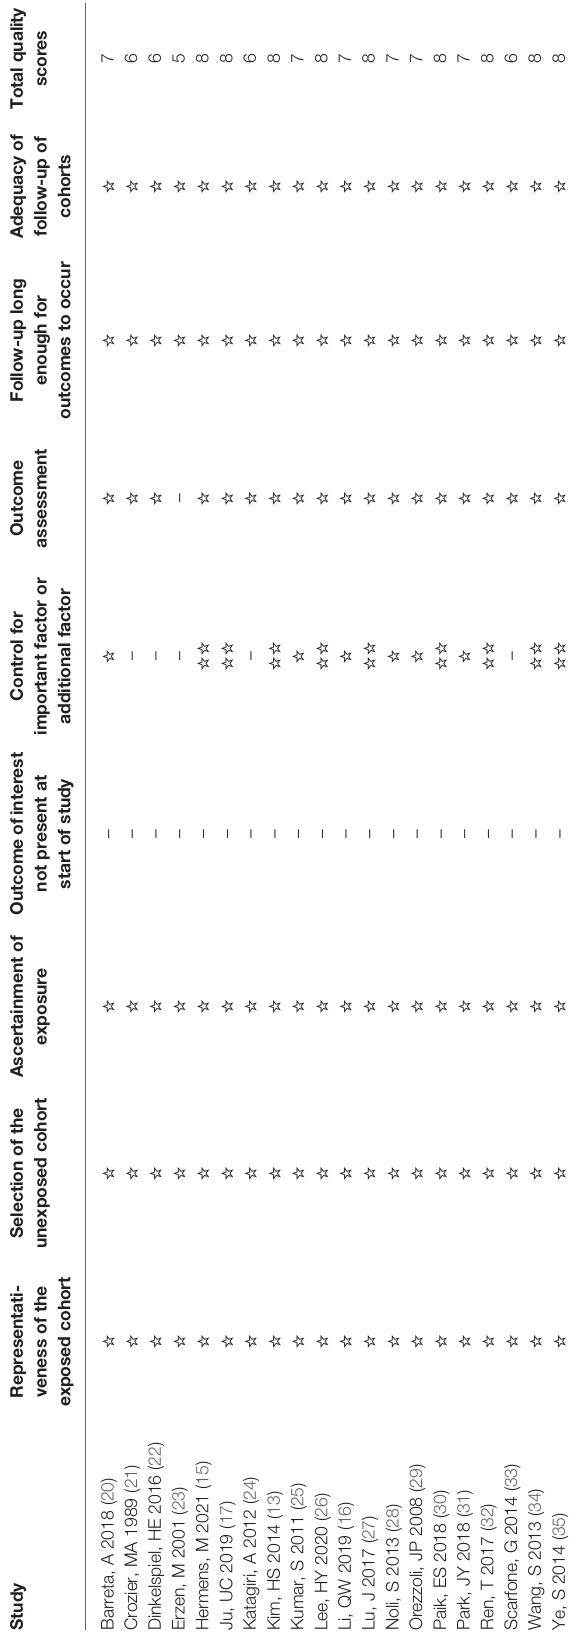
Figure 5 ] of OCCC patients were not signi fi cantly